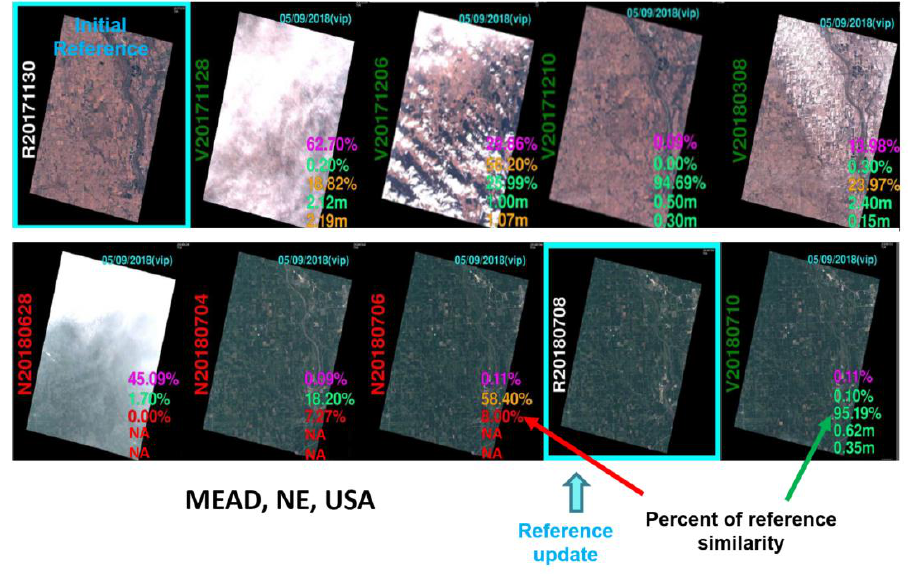
Figure 50. Time series monitoring for reference image updating (MEAD site).